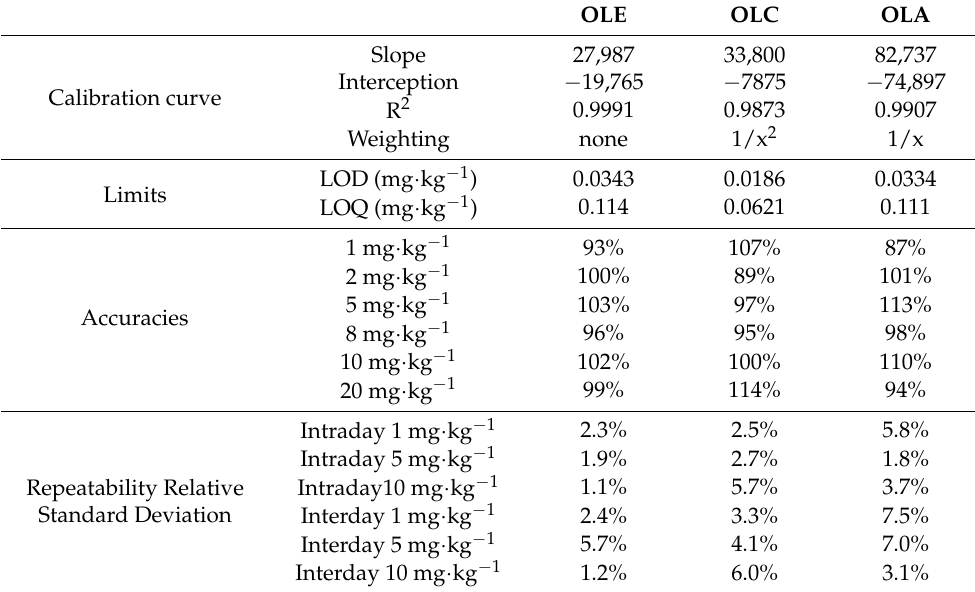
Table 2. Method validation parameters for OLE, OLC, and OLA.